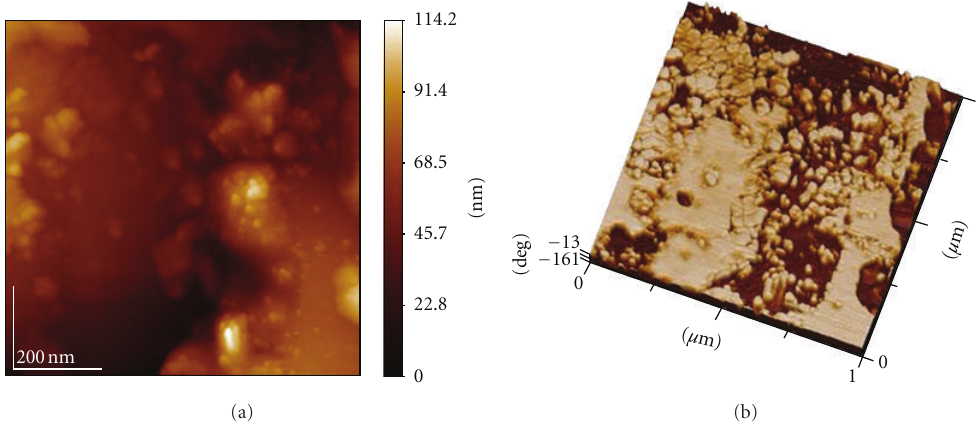
Figure 12: Surface structure analyzed by means of AFM of heat-treated hydroxyapatite at 700 ◦ C. (a) Topography and (b) Phase.